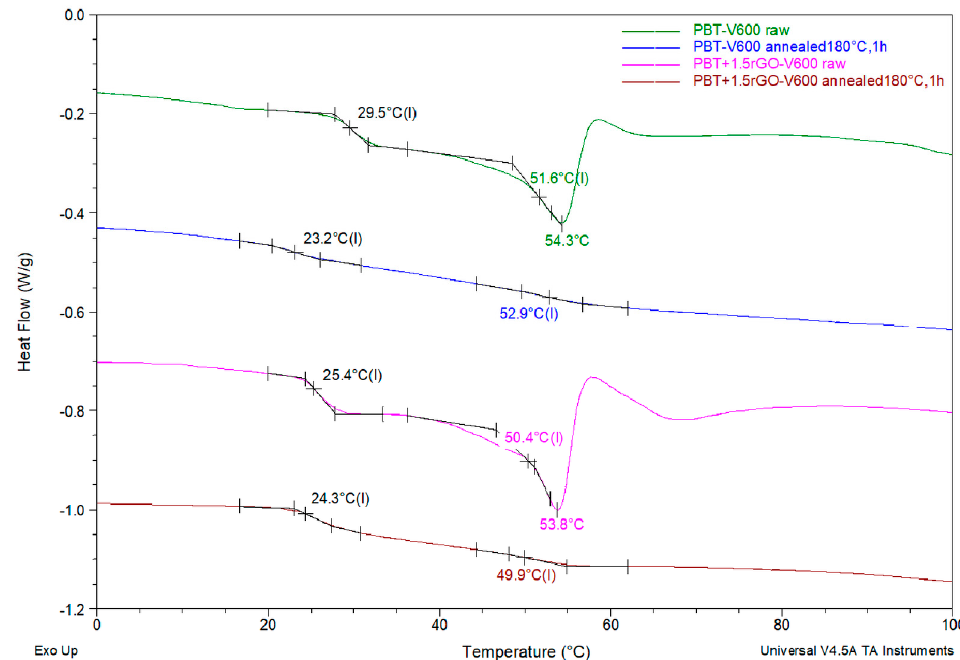
Figure 11. DSC curves of the studied fibers from PBT and PBT with the addition of 1.5 wt % of rGO both before and after annealing in hot air (180 °C for 1 hour). Analysis of the glass transition temperature range. The inflection values of T g1 (black labels) and T g2 (colored labels) are marked on curves.